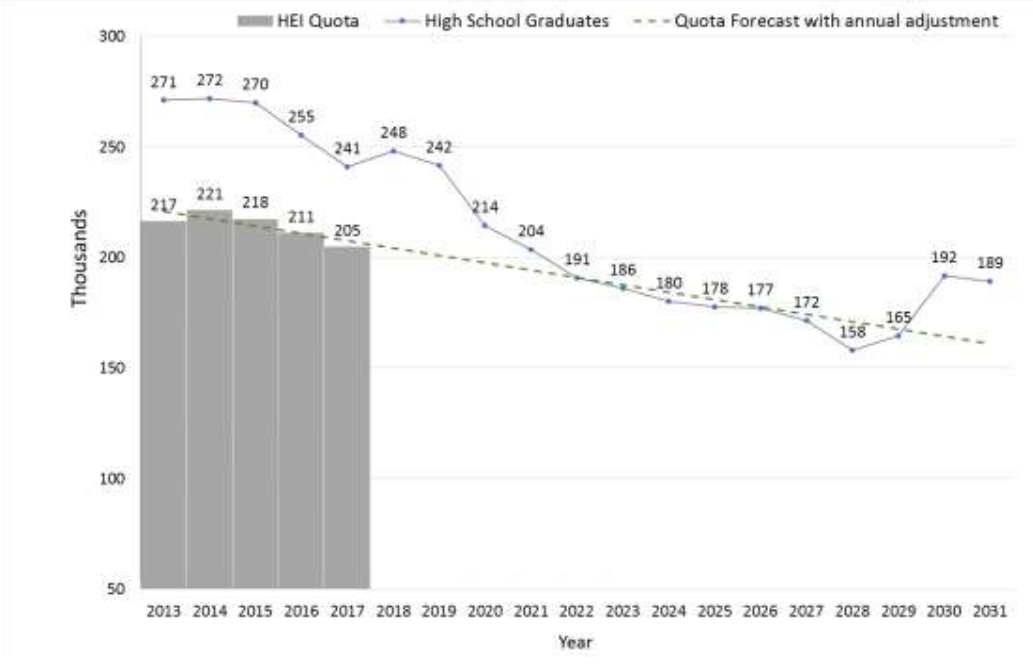
Figure 2. High School Graduates Number Vs Admission Quota 2013 - 2031 (Source: